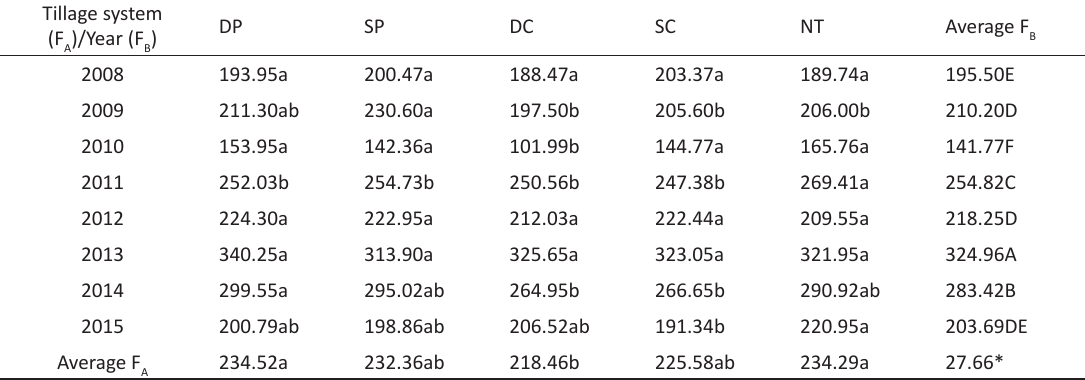
Table 10. 1000-grain weight (g) of maize using different tillage systems Tillage system (F